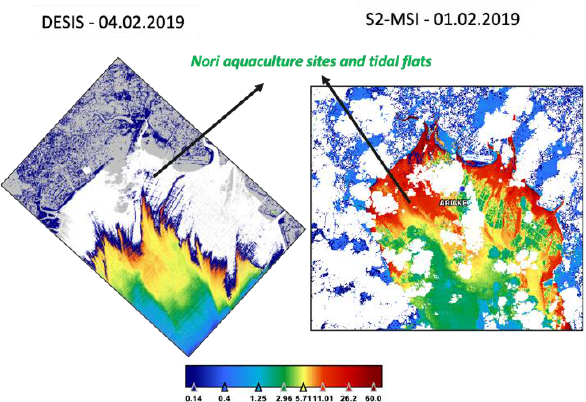
Figure 5 . Comparison of DESIS (left) and S2-MSI (right) derived chlorophyll-a concentration at Airike. The pin on the S2 image shows the position of the AERONET-OC station and the colorbar indicates chlorophyll-a concentration in mg/m 3 .